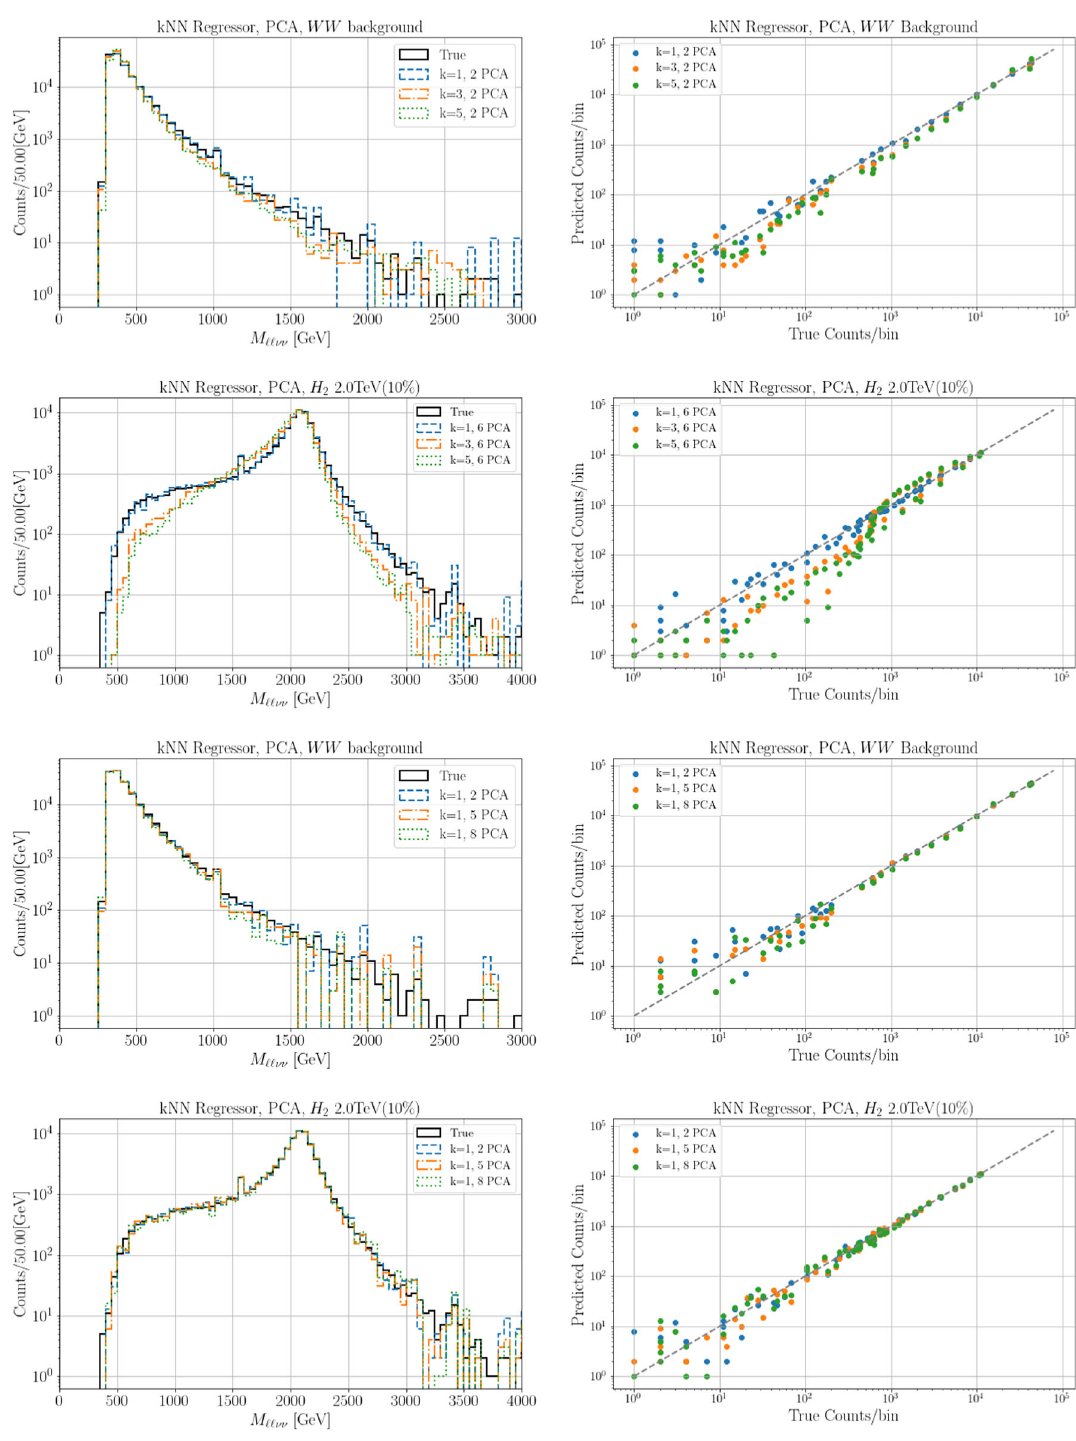
Fig. 3 Results for the tuning of the number of nearest neighbors, k , and number of principal components (PCA) of the latent space. In the four upper panels we display k = 1, 3, and 5, keeping PCA fixed at its best value. In the four lower panels we display PCA = 2, 5, and 8, keeping k fixed at its best